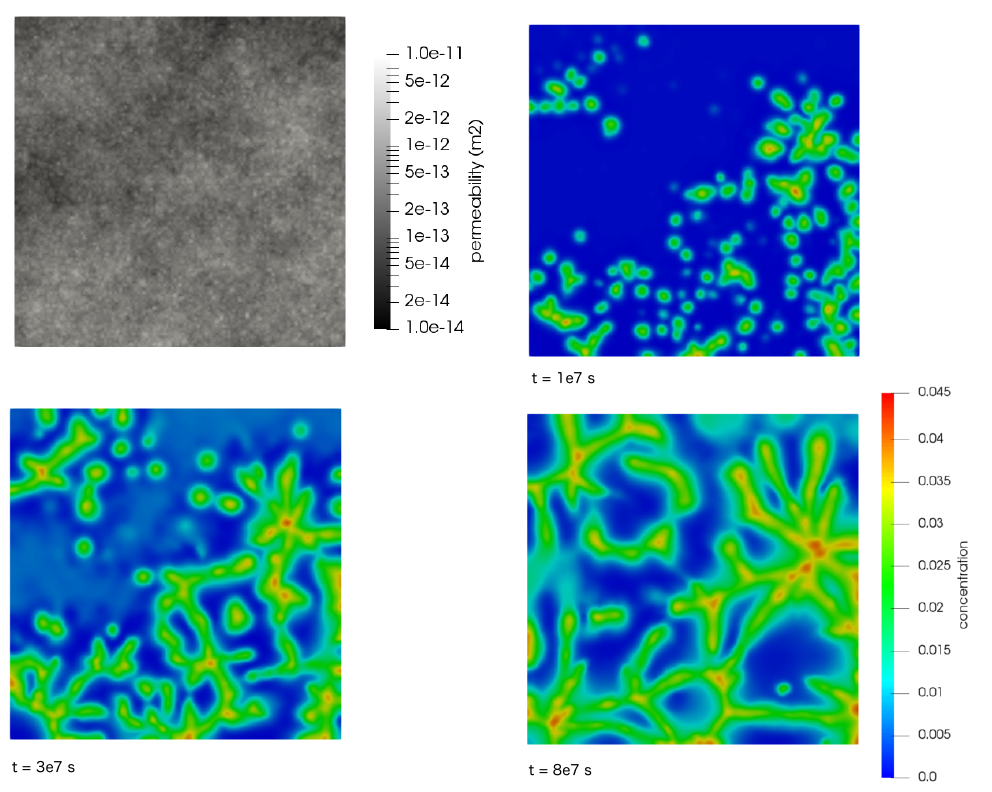
Figure 10. Evolution of convective mixing in the heterogeneous fractional Lévy motion model for a horizontal slice 0.5 m below the top boundary. Time in seconds.